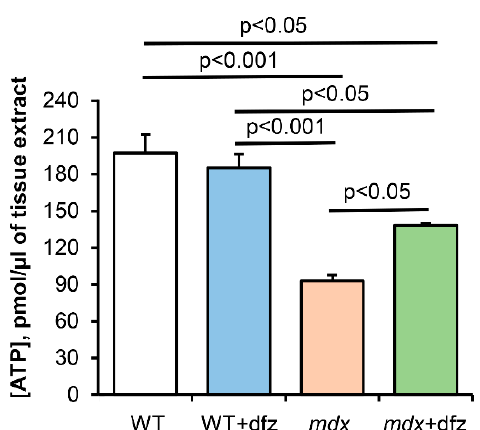
Figure 4. The level of ATP in the extract of skeletal muscle tissue of mice after four weeks of treatment with deflazacort. The data are presented as means ± SEM ( n = 3).